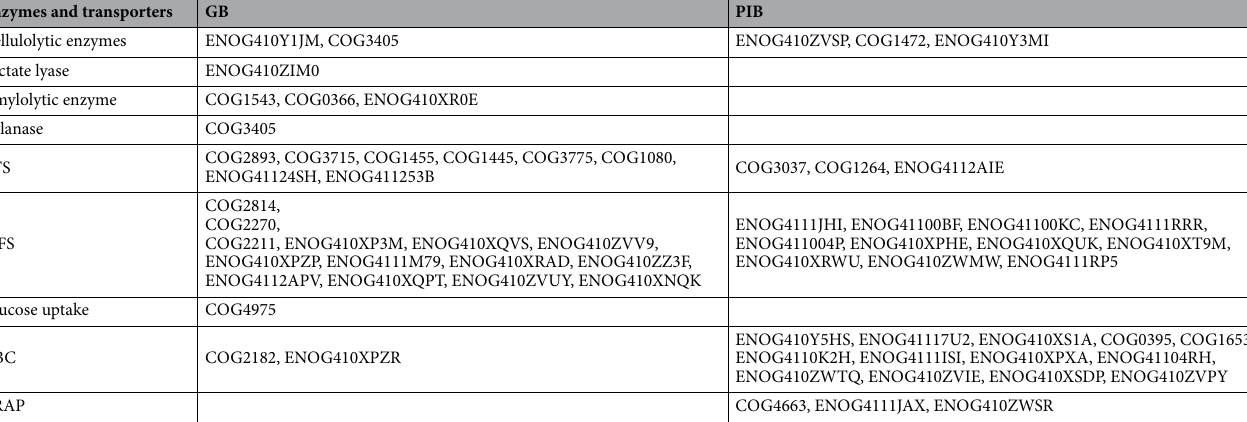
Table 2. COGs/NOGs involved in the GB and PIB dietary components degradation and their subsequent transportation in bacterial